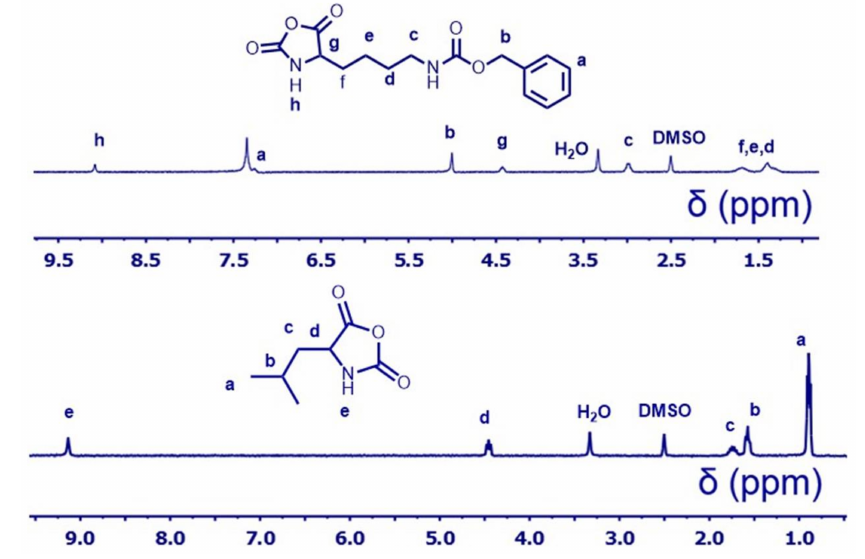
Figure 2. 1 H NMR spectrum of L -lysine(CBZ)-NCA and L -leucine-NCA in DMSO- d6